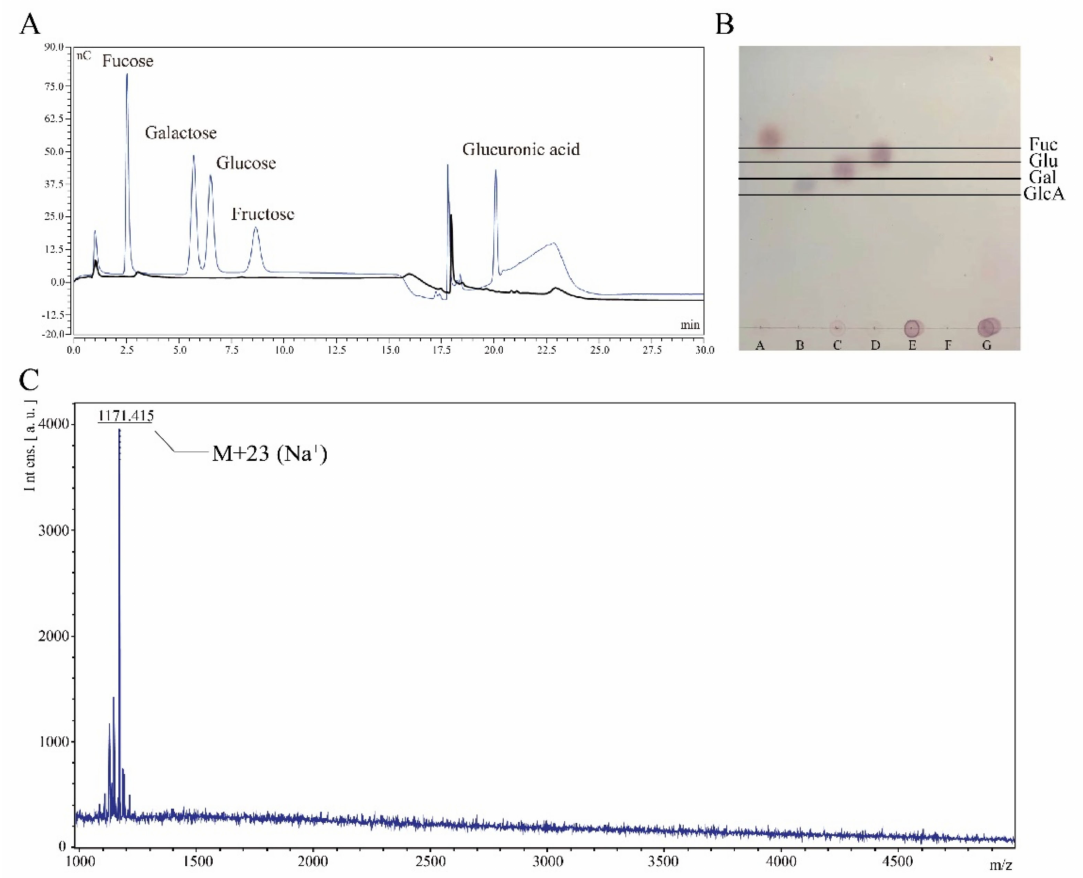
Figure 5. Characterization of enzymatic hydrolysates. ( A ) Purified colanic acid was hydrolyzed by colanic acid hydrolase, and the hydrolysate was assayed by high-performance liquid chromatog- raphy (HPLC). The bold curve was the sample, and the other curve was the standard curve for the different types of monosaccharide. ( B ) Purified colanic acid was hydrolyzed by colanic acid hydro- lase, and the hydrolysate was assayed by thin-layer chromatography (TLC). A, B, C, D, E, F, and G are fucose, glucuronic acid, galactose, glucose, colanic acid, purified colanic acid hydrolase (CAE), and the hydrolysate, respectively. ( C ) The molecular weight of the hydrolysate was determined by matrix assisted laser desorption ion flight mass spectrometry